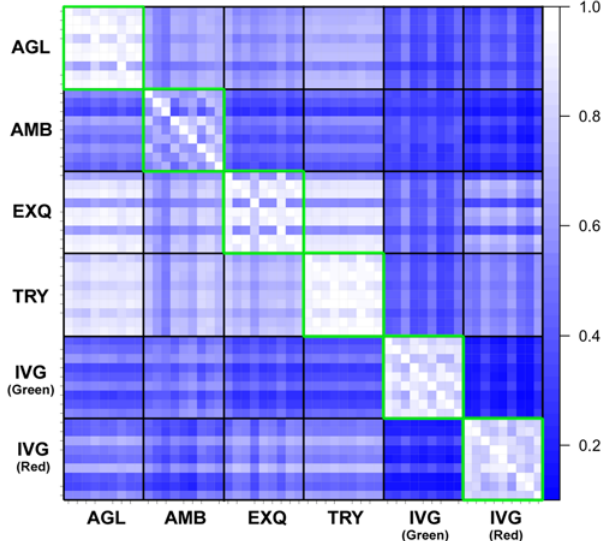
Figure 5. Agreement in the list of differentially expressed microRNAs. This graph indicates the concordance of microRNAs identified as differentially expressed for pairs of platforms, labeled as X and Y. A list of differentially expressed microRNAs between human liver vs. human prostate was generated for each platform (using the 309 common microRNAs with $ two-fold change) and compared for commonality to other platforms. No filtering related to the qualitative detection call was performed. The color of the square in the matrix reflects the percent overlap of microRNAs on the list for the platform X (listed in column) that are also present on the list for the platform Y (listed in row). A light-colored square indicates a high percent overlap between the microRNA lists at both platforms. A dark-colored square indicates a low percent overlap, suggesting that most microRNAs identified in platform X were not identified in platform Y. Note: the graph is asymmetric and not complementary, for the same reason as in Figure 4B and